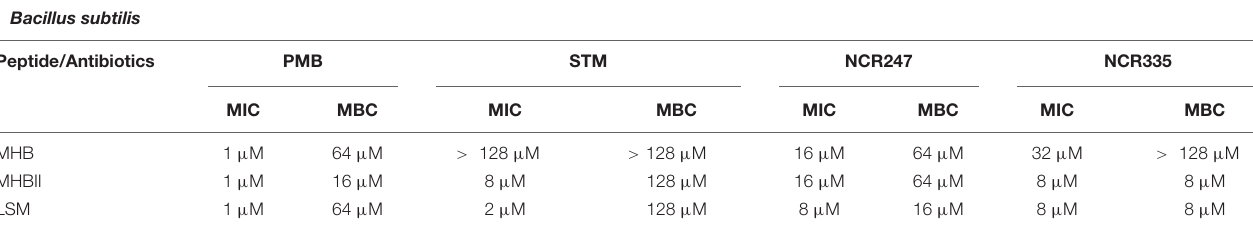
TABLE 2 | Minimal inhibitory concentration (MIC) values determined by colorimetric assay (resazurin) and minimal bactericidal concentrations (MBC) determined by conventional plating method on B. subtilis . Bacillus subtilis Peptide/Antibiotics